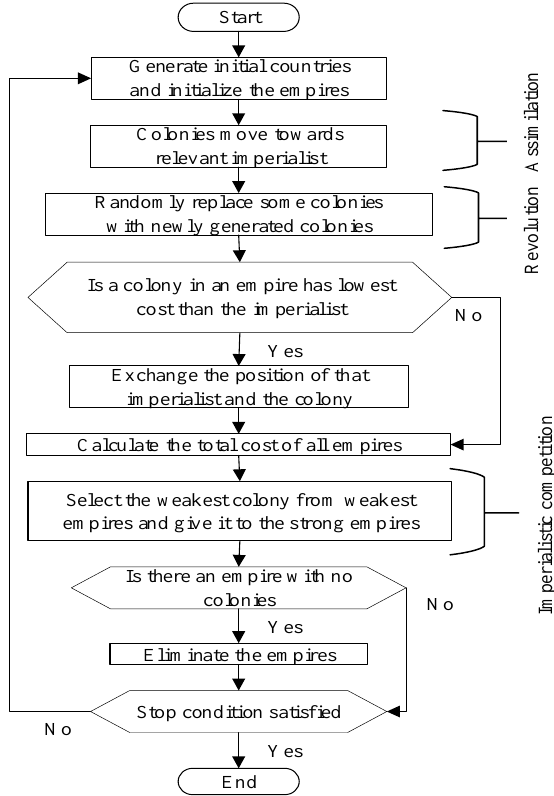
Figure 4. Imperialistic competition algorithm.